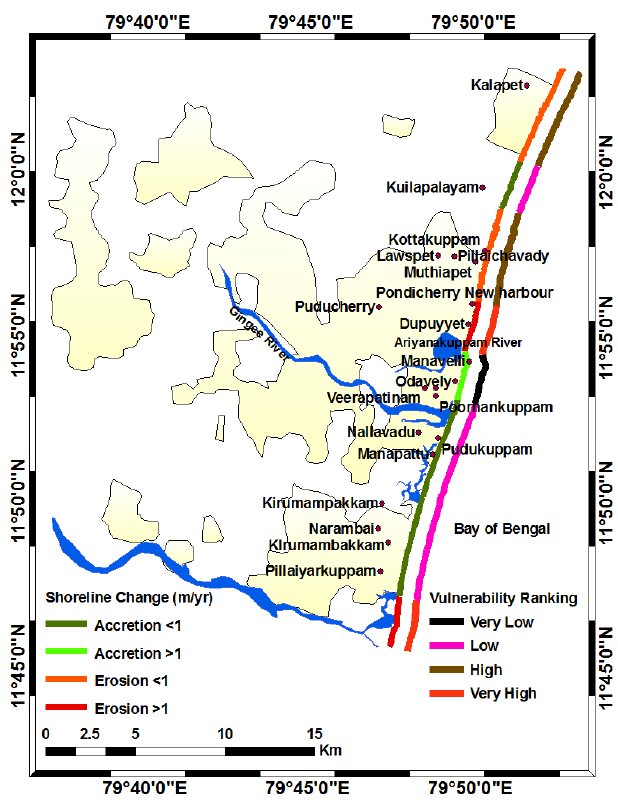
Fig. 6. Vulnerability ranking map of shoreline change